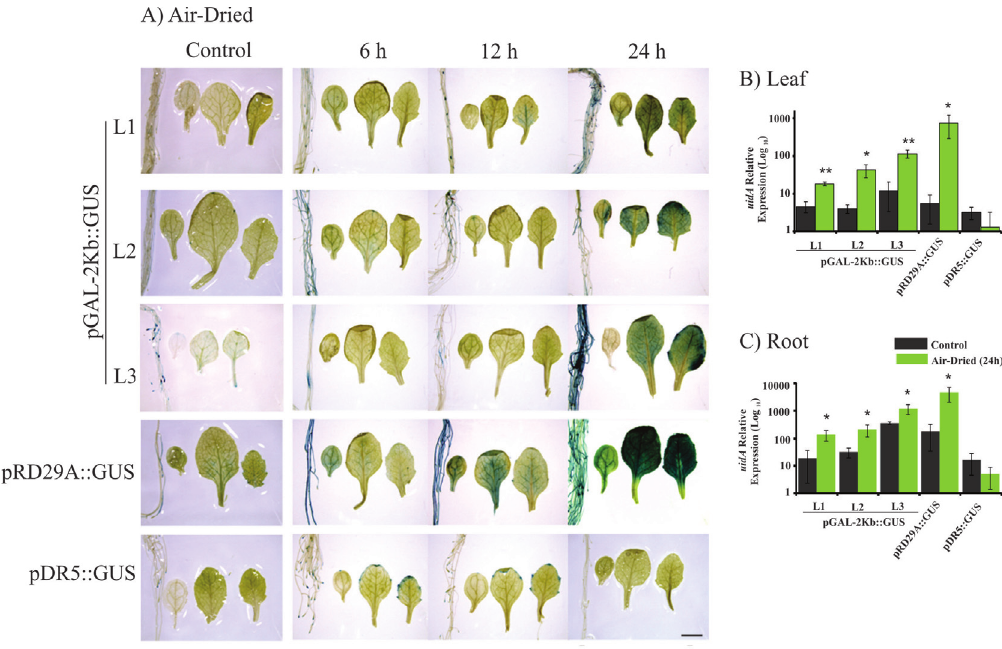
Figure 3 - Histochemical analysis and expression profile analyses of the GUS reporter gene under control of the pGAL -2kb promoter. The order of the sam- ple photos is as follows: root, cotyledonal leaf, young leaf and totally expanded leaf. A) The leaves and roots of plants grown under normal conditions and air-dried treatment (6, 12 and 24 h) were compared to the pRD29::GUS and pDR5::GUS plants under normal conditions and treated (6, 12 and 24 h). The data shown are representative of three independent lines (n = 3). B and C). The expression levels of uidA mRNA in leaves and roots under control (non-treated) and air-dried treatment. Values are means (cid:5) SD (n = 3). The relative expression values, represented on the y-axis, were obtained by qPCR ex- perimentsandcalculatedusingthe2 - (cid:7)(cid:7) Ct method.TheAt4g34270andAt4g38070geneswereusedasendogenouscontrolstonormalizedata.Asterisksindi- cate significant differences of samples under air-dried treatment and non-treatment (Student’s t -test * p < 0.05 and ** p < 0.01). Total RNA was extracted from the leaves and roots of three independent T3 lines of 2-week-old transgenic plants after 24 h of drought (air-dried) treatment. Scale bars = 2